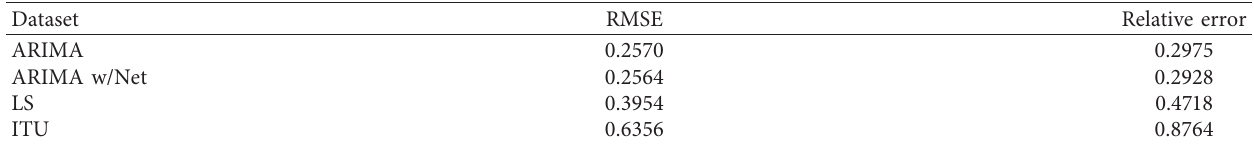
Table 16: ARIMA, ARIMA with neural network, LS, and ITU errors for “data2.”